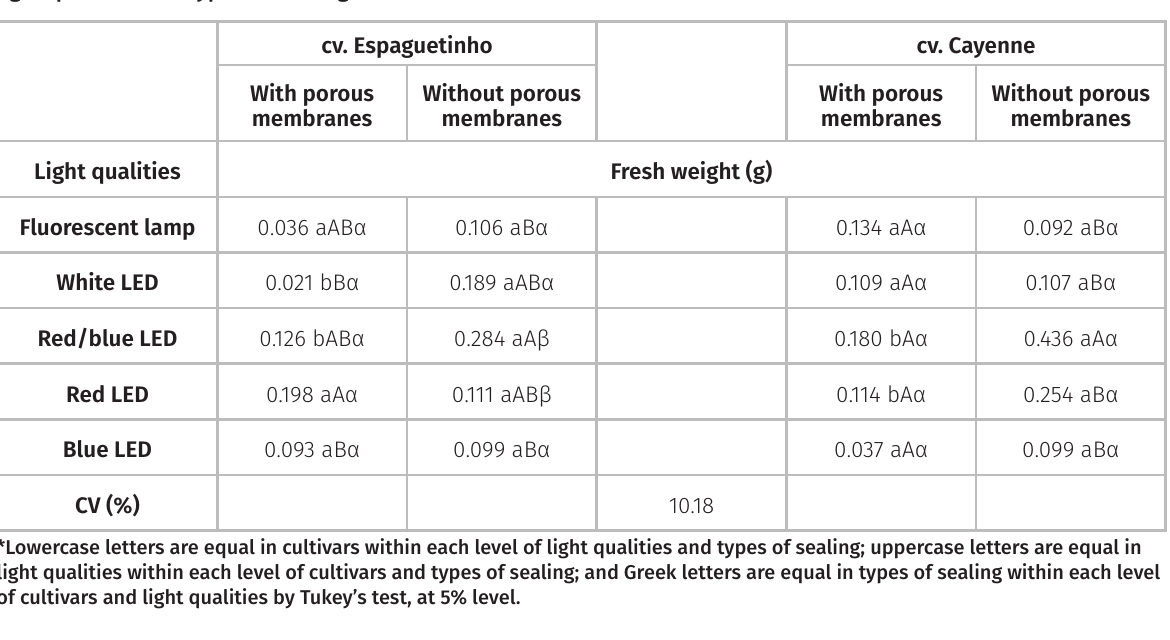
Table II. Fresh weight of Capsicum frutescens cultivars (‘Espaguetinho’ and ‘Cayenne’) cultivated under different light qualities and types of sealing.